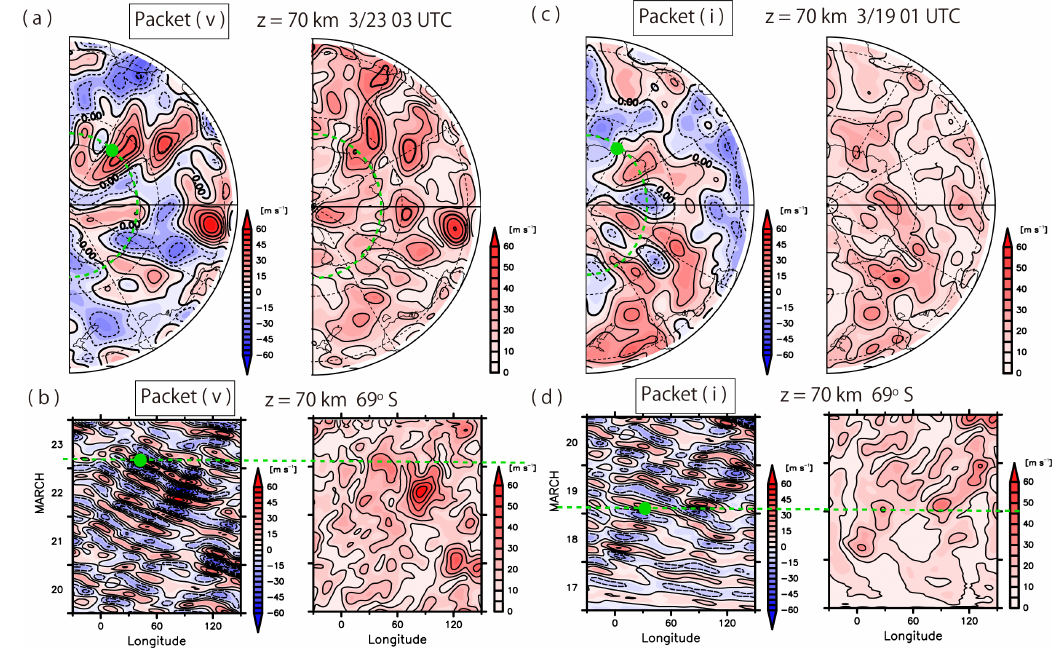
Figure 11. Snapshots of the zonal wind components and their envelope function of the large-scale inertia–gravity waves (a) at the height of 70km at 03:00UTC, 23 March 2015, corresponding to the packet (v), and (c) at the height of 70km at 01:00UTC, 19 March 2015, corresponding to the packet (i). Hovmöller diagrams of the zonal wind components and their envelope function of the large-scale inertia– gravity waves at the height of 70km at 69 ◦ S for the period (b) from 20 to 23 March and (d) from 17 to 20 March. The green dashed curves in (a) and (c) denote the cross section taken in (b) and (d) , and vice versa. The green circles are locations of traced wave packets by the method discussed in the text. The contour intervals are 10ms − 1 . The data are from the NICAM simulation. Table 3. The results of the manual wave packet tracing and the ray tracing. Manual wave packet tracing Ray tracing Longitude ( ◦ E) Latitude ( ◦ S) Altitude (km) Longitude ( ◦